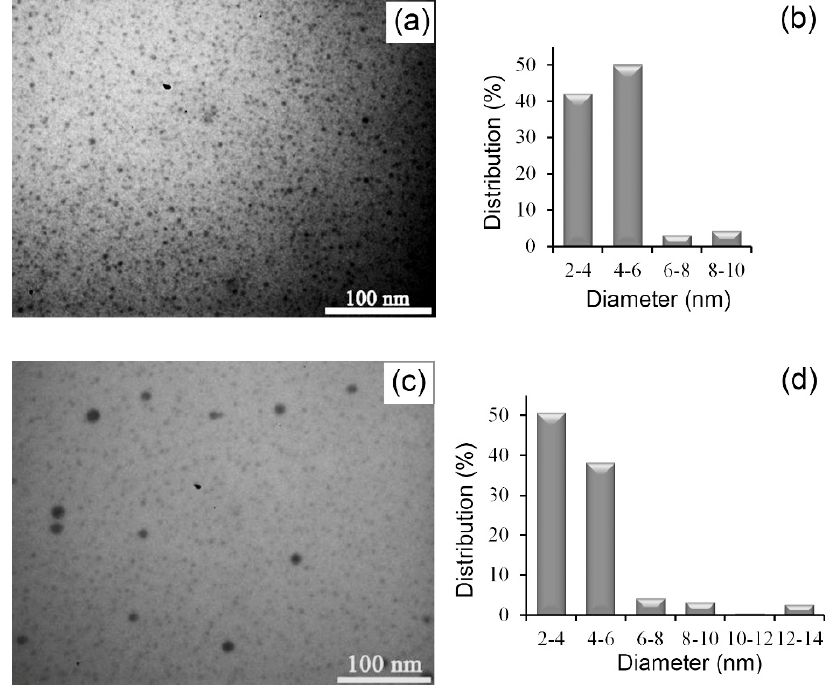
Figure 5. ( a , c ) TEM images and ( b , d ) sizes histograms of AgNPs nanocomposites synthesized using various different reducing agents. ( a , b ) NaBH 4 and ( c , d ) formaldehyde.